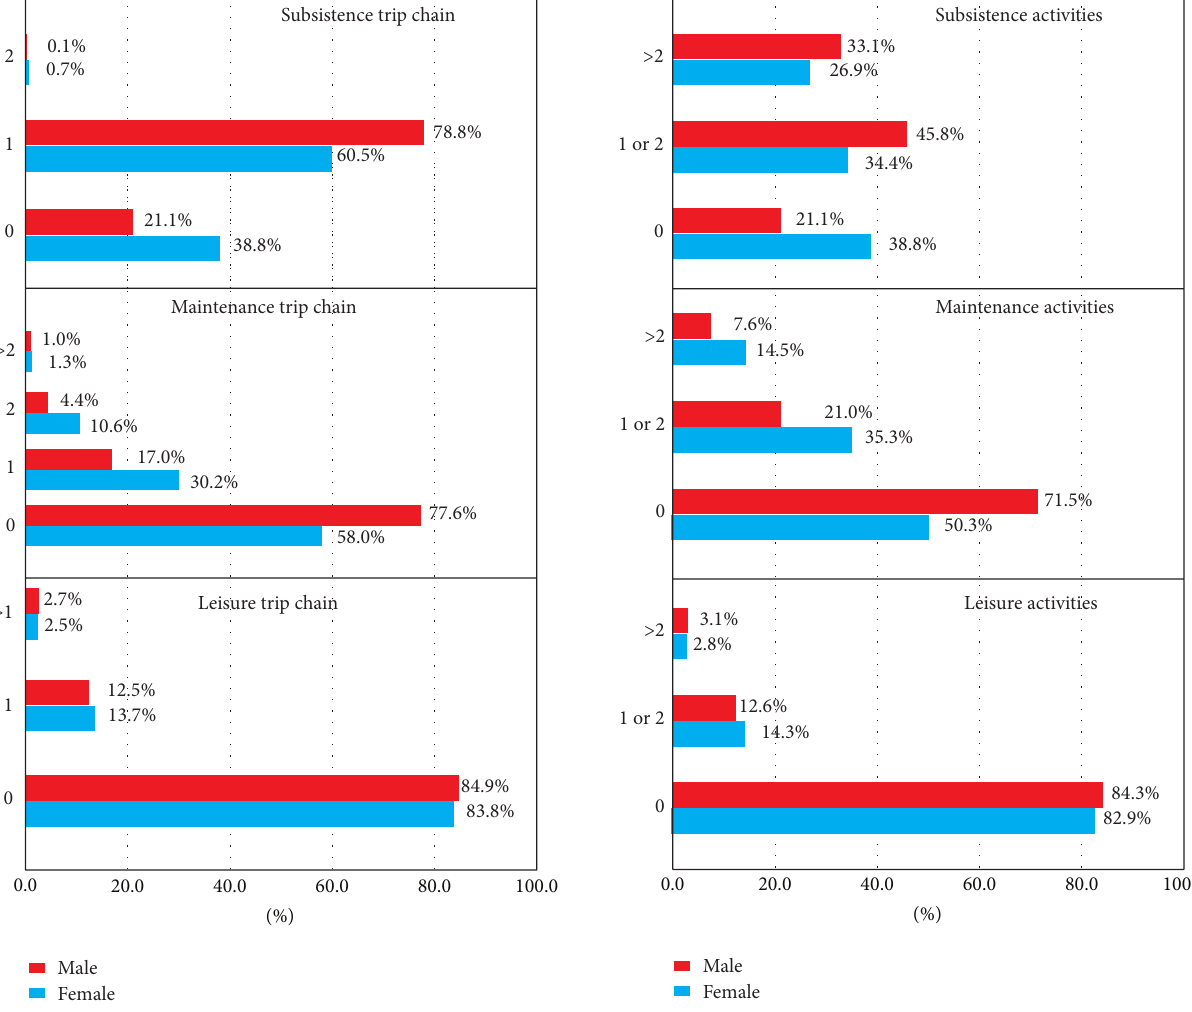
Figure 1: Distribution of trip chain numbers and activities between male and